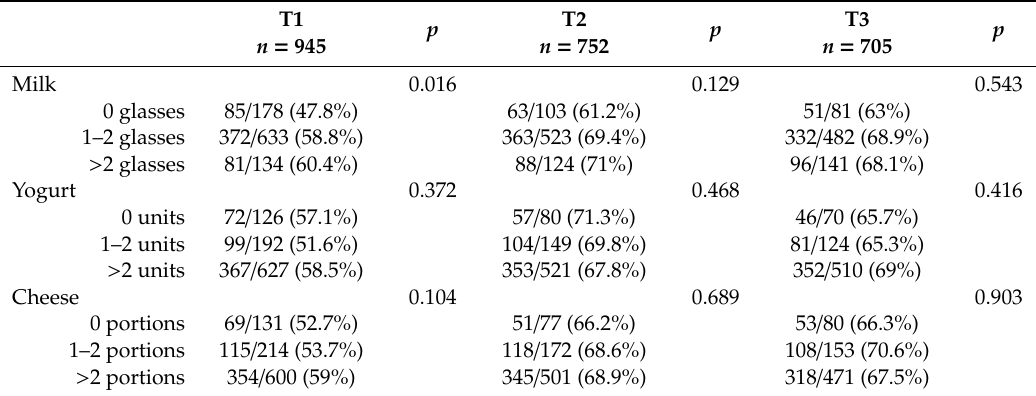
Table 2. Percentage of pregnant women with UIC ≥ 150 µ g / dL related to dietary intake, iodized salt intake, iodine supplementation, and